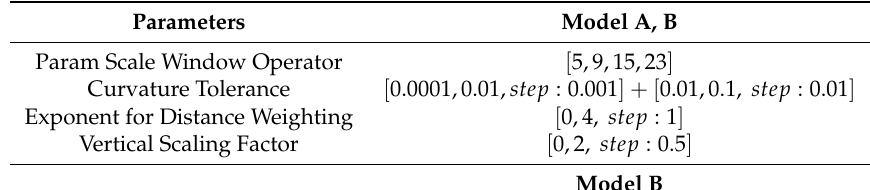
Table 1. Parameters used in the sensitivity analysis of the TFE